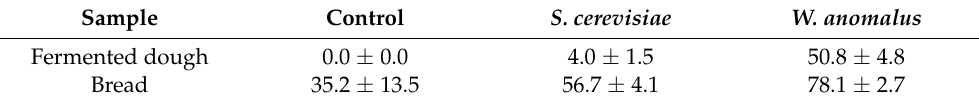
Table 2. α -Gliadin hydrolysis percentage in bread making with baker’s yeast and W. anomalus .